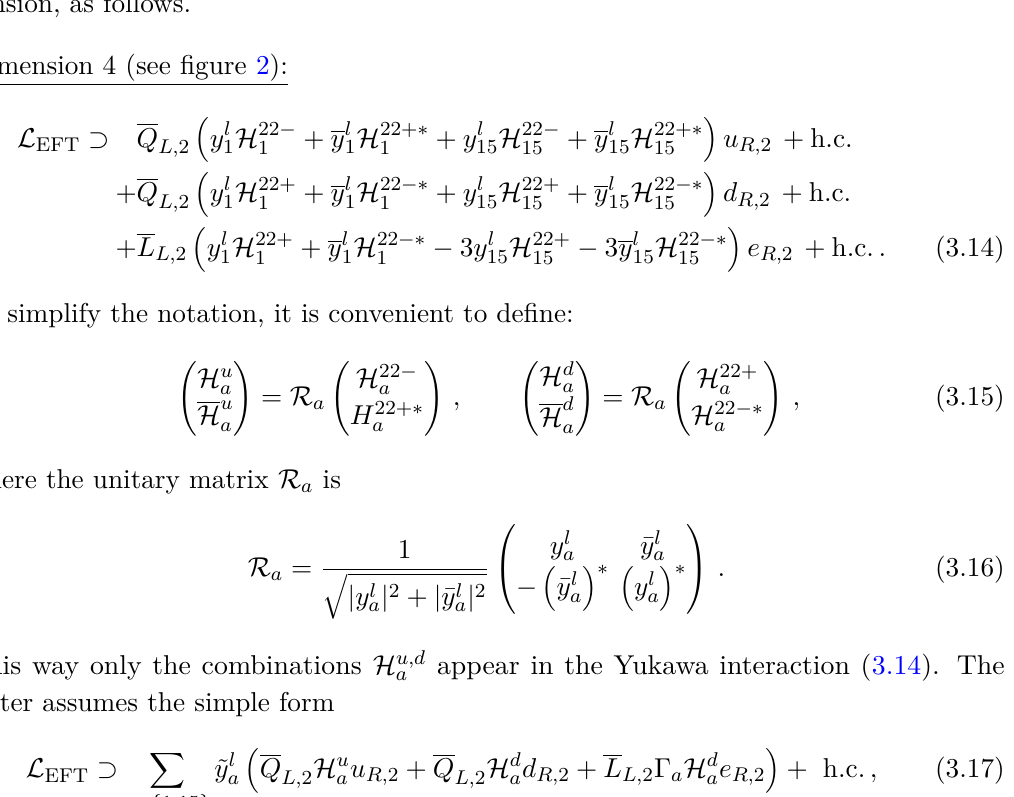
Figure 4 . Feynman diagrams that contribute to the 1–1 element of the Yukawa matrices, once the heavy Higgs components running along the internal lines are integrated out at Λ the diagram on the left is essential in order to provide enough freedom to parametrize the 1–1 entry independently of the 1–2 and 2–1